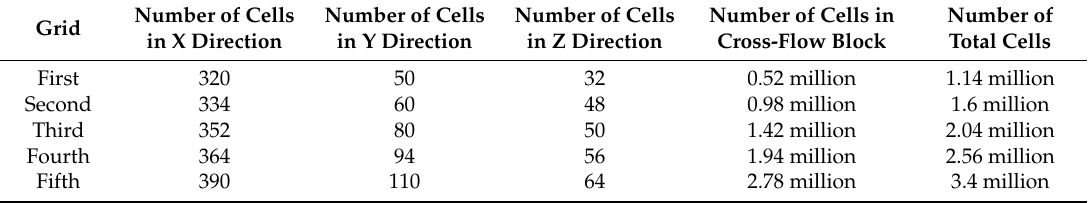
Table 3. The values of A up to 32 Hz in Equation (5) as a function of frequency [7].